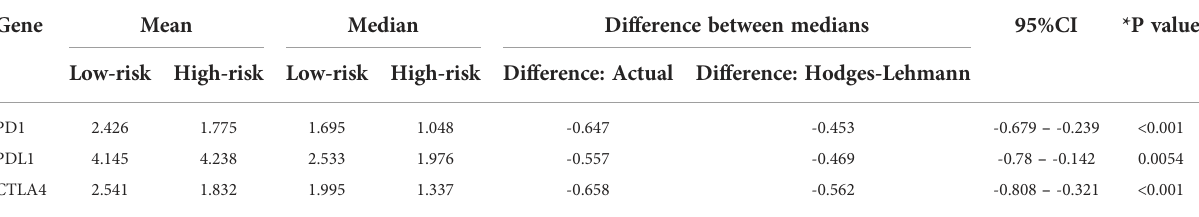
TABLE 2 The differential expression analysis results of PD1, PDL1, and CTLA4 in the high-risk and low-risk patients of TCGA-LUAD. Gene Mean Median Difference between medians 95%CI *P value Low-risk High-risk Low-risk High-risk Difference: Actual Difference: Hodges-Lehmann